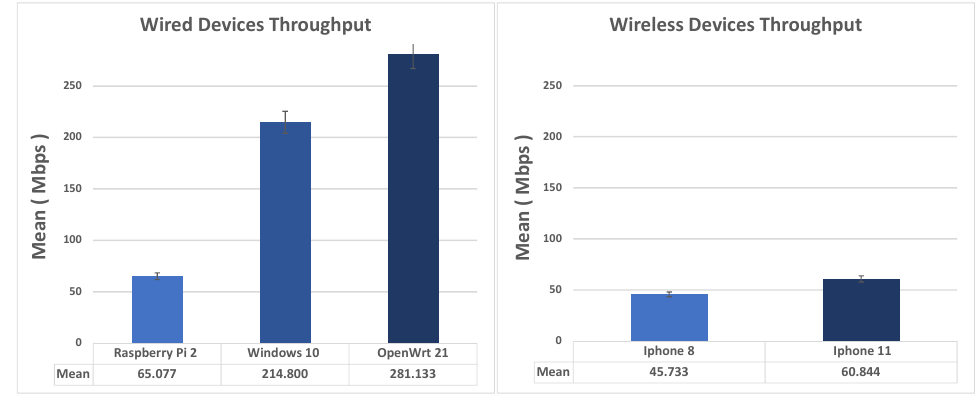
Figure 7. Comparison of the average Throughput in IPsec XAUTH Road Warriors scenario.